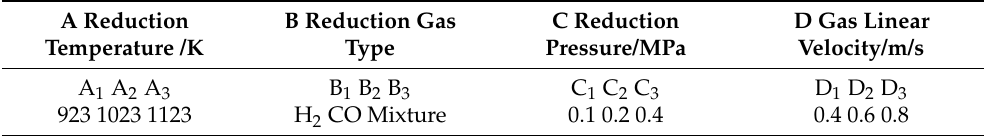
Table 4. Levels of each